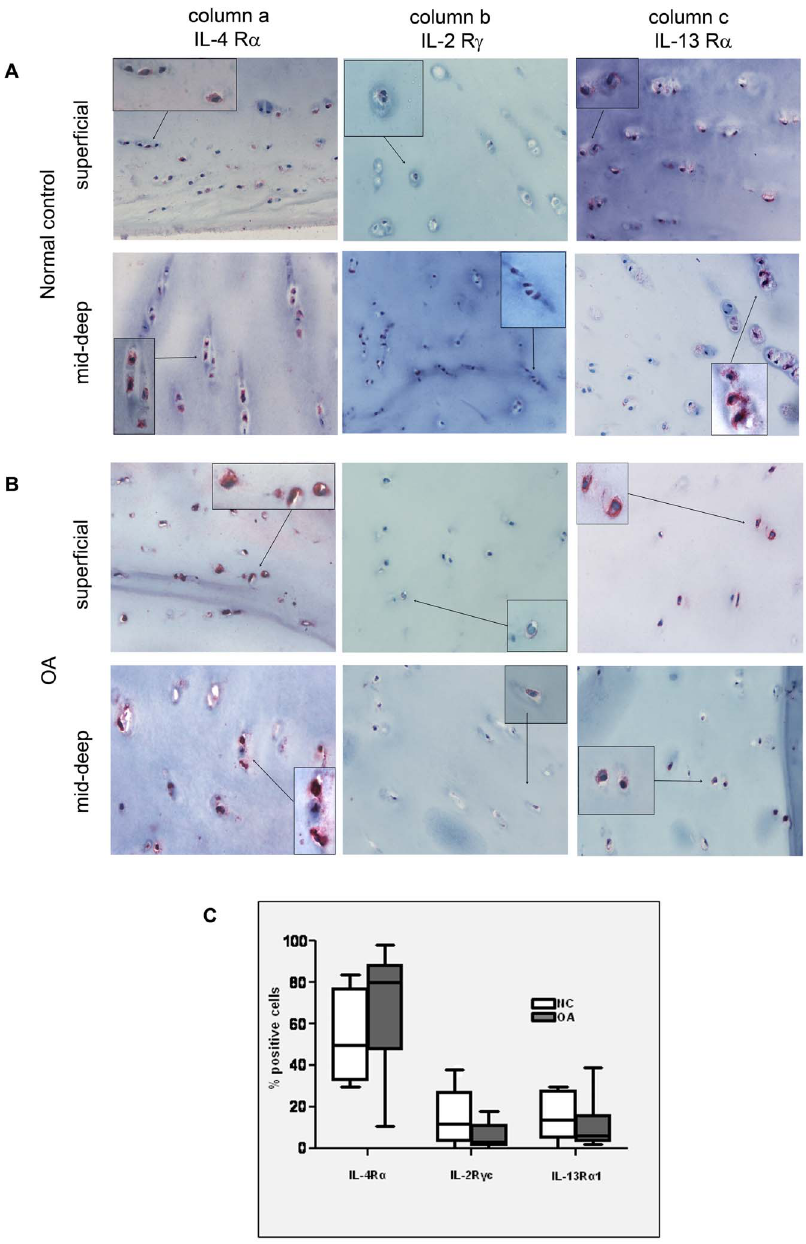
Figure 2. Analysis of IL-4R subunits in normal and osteoarthritic cartilage. A and B : representative examples of IL-4R subunits staining in control (NC, A ) and OA ( B ) cartilage (original magnification 6 100) with details of superficial and mid-deep layer. Insets: higher magnification views (original magnification 6 200). C : Percentage of positive cells expressing the three IL-4R subunits in controls (NC, white pattern, n=5), and OA cartilage (dark pattern, n=6), in the mid-deep layers. Comparison of NC and OA data was performed by the Mann-Whitney U test (p=ns). Boxes indicate the 25% and 75% percentiles, whiskers indicate the minimum to maximum values, and bars indicate the median.